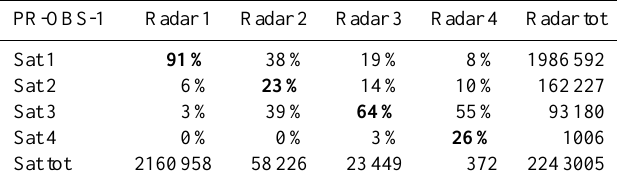
Table 11. Contingency table for the multi-categorical statistics for PR-OBS-2 as compared with radar-derived rain fields.